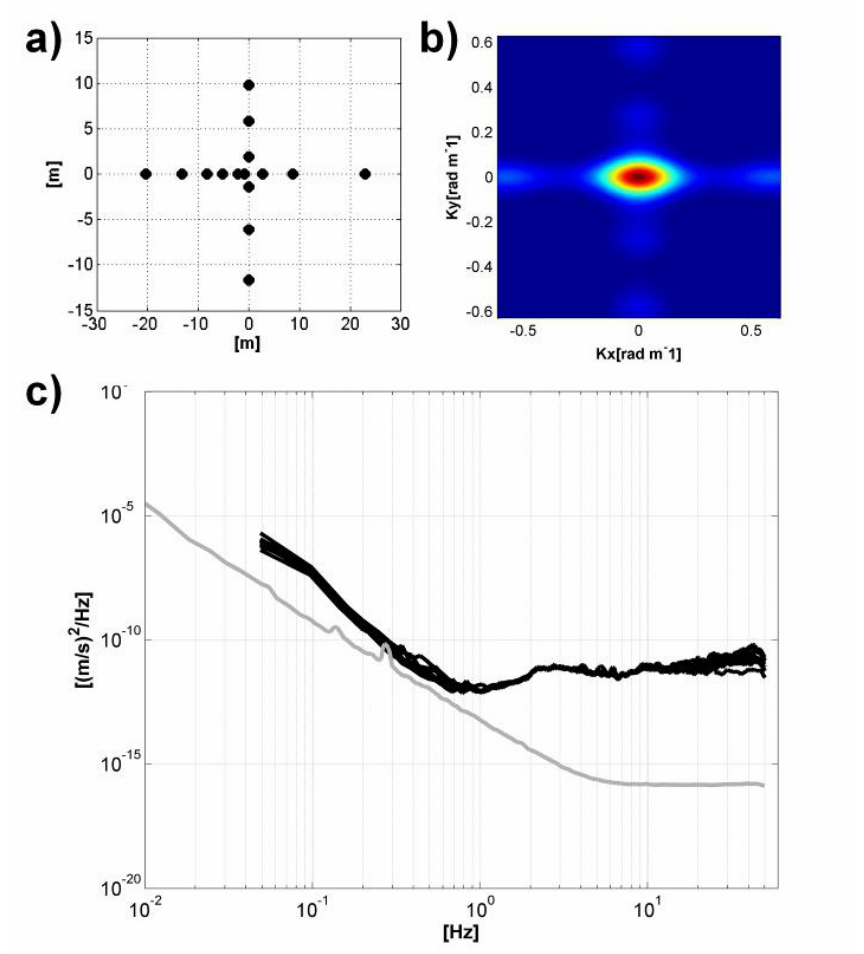
Figure 6. (a) Array geometry. (b) array response function. (c) experimental ( black lines ) and self-noise ( gray lines ) WSU